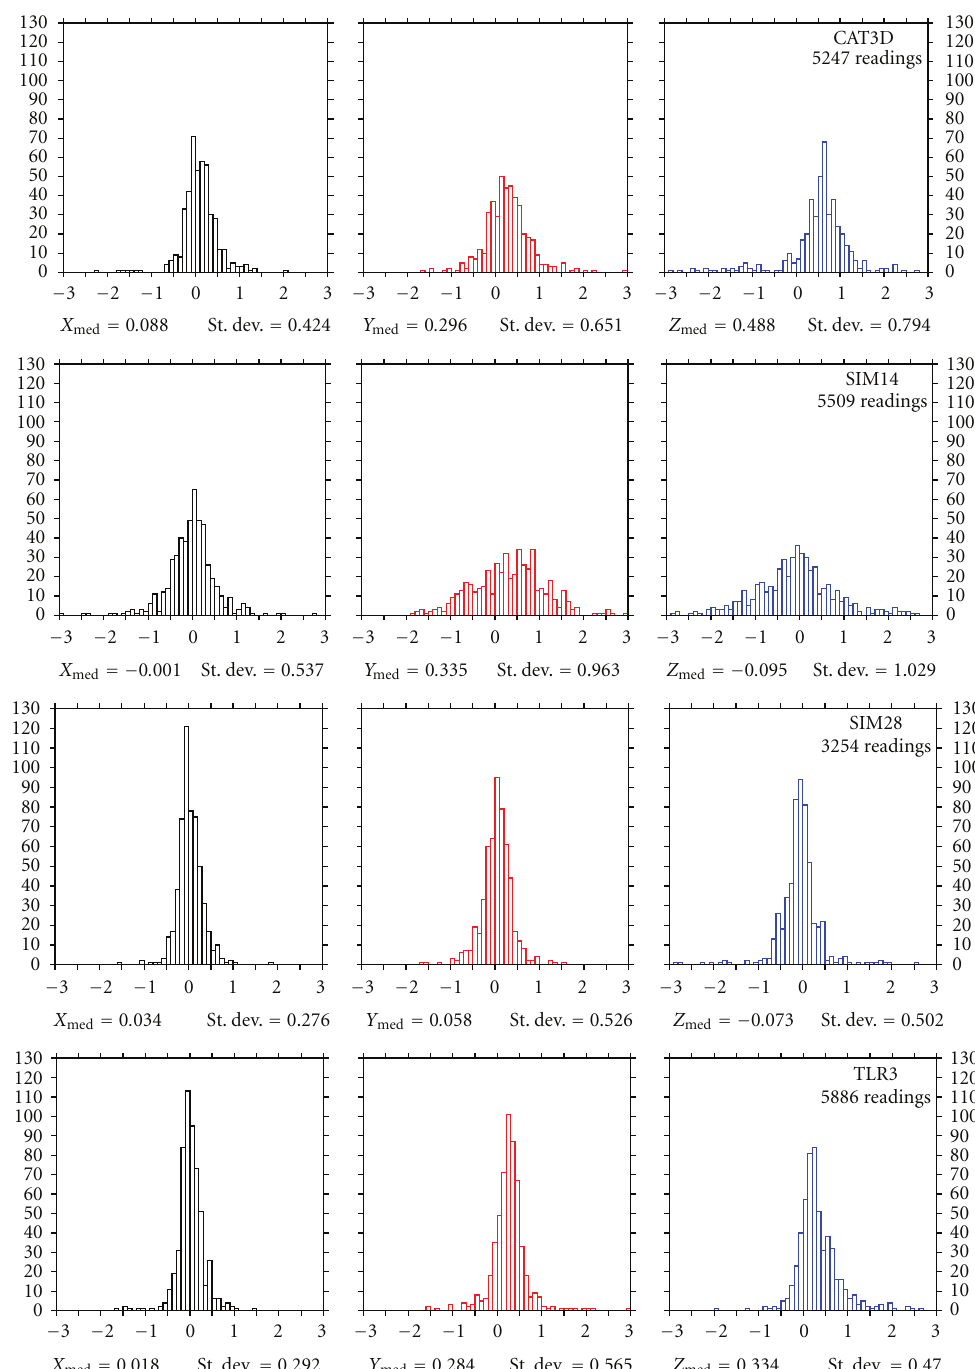
Figure 15: Distribution of the shift between inverted and original locations for the di ff erent methods (from top to bottom) along the three cartesian axes (from left to